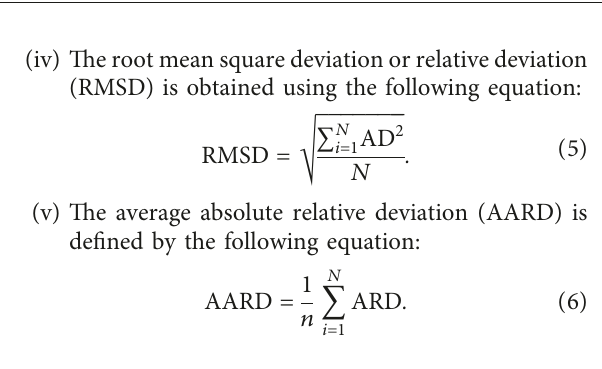
Figure 3: C18 :0, stearic acid C Table 2: Fatty acids selected for the property evaluation classified by name, CAS number, and molecular